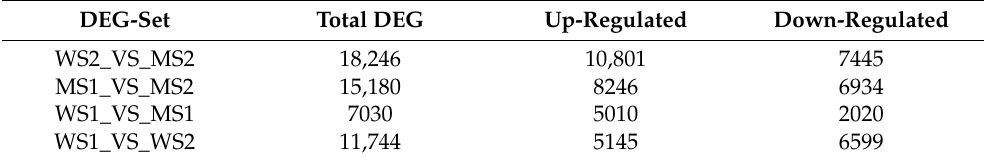
Table 3. DEGs identified from five different comparisons. DEGs: differentially expressed genes. DEG-Set Total DEG